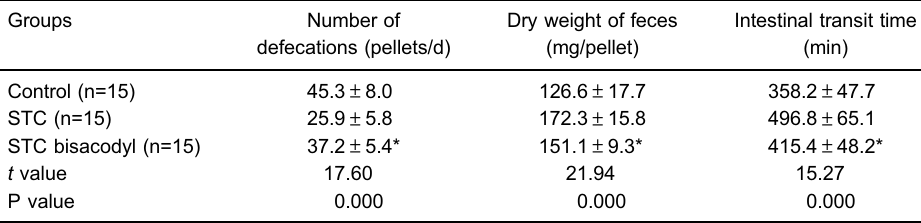
Table 2. Comparison of defecation condition among control, slow transit constipation (STC) control, and STC bisacodyl groups after 1 month of diphenoxylate treatment.